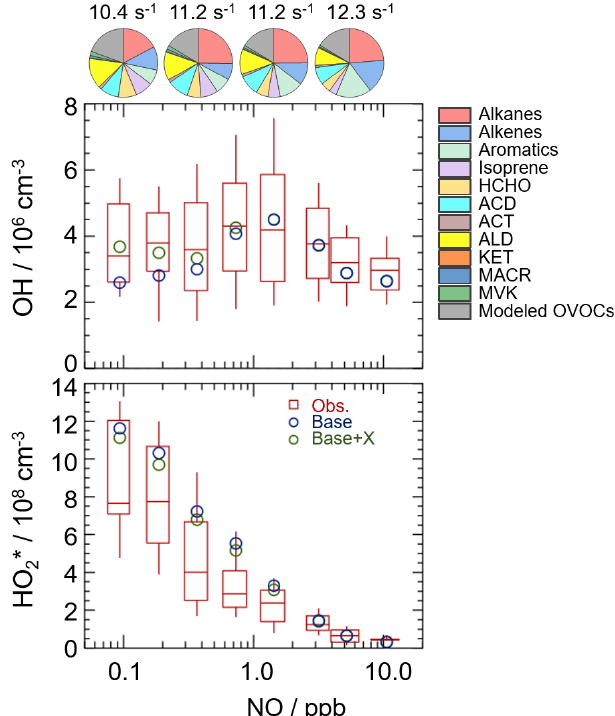
∗ radicals. The red box– 2 whisker plots give the median, the 75th and 25th percentiles, and the 90th and 10th percentiles of the HO x observations. The blue circles show the median values of the HO x simulations by the base model, and the green circles show the HO x simulations by the model with the X mechanism. Total VOC reactivity and their organic specia- tion are presented by pie charts at the different NO intervals at the top. Only daytime values and NO concentration above the detec- tion limit of the instrument were chosen. ACD and ACT denote acetaldehyde and acetone, respectively. ALD denotes the C 3 and higher aldehydes. KET denotes ketones. MACR and MVK, which are both the isoprene oxidation products, denote methacrolein and methyl vinyl ketone,